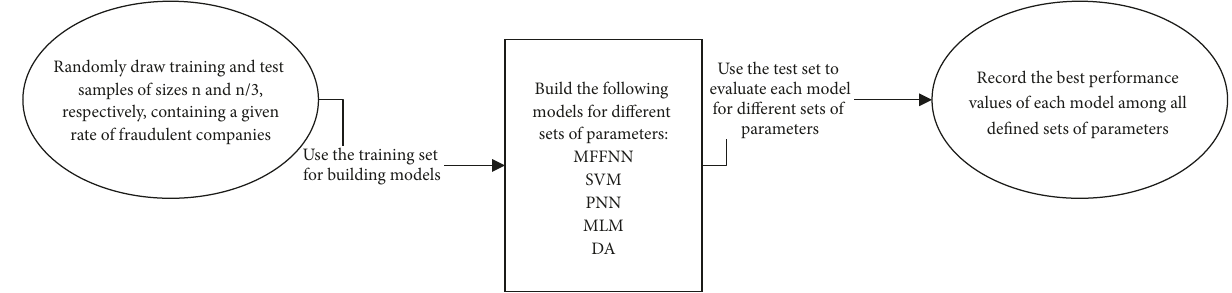
Figure 2: The process of selecting samples, building and evaluating models in each iteration.